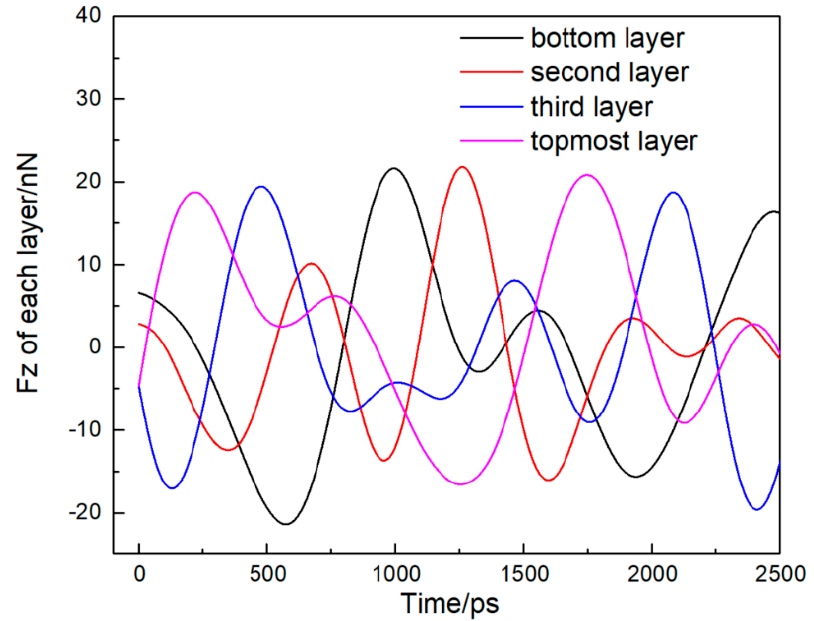
Figure 3. Fz to exfoliate each layer varying with time in four-layer graphene system, when the vertical upward velocity was 0.4 Å/ps.